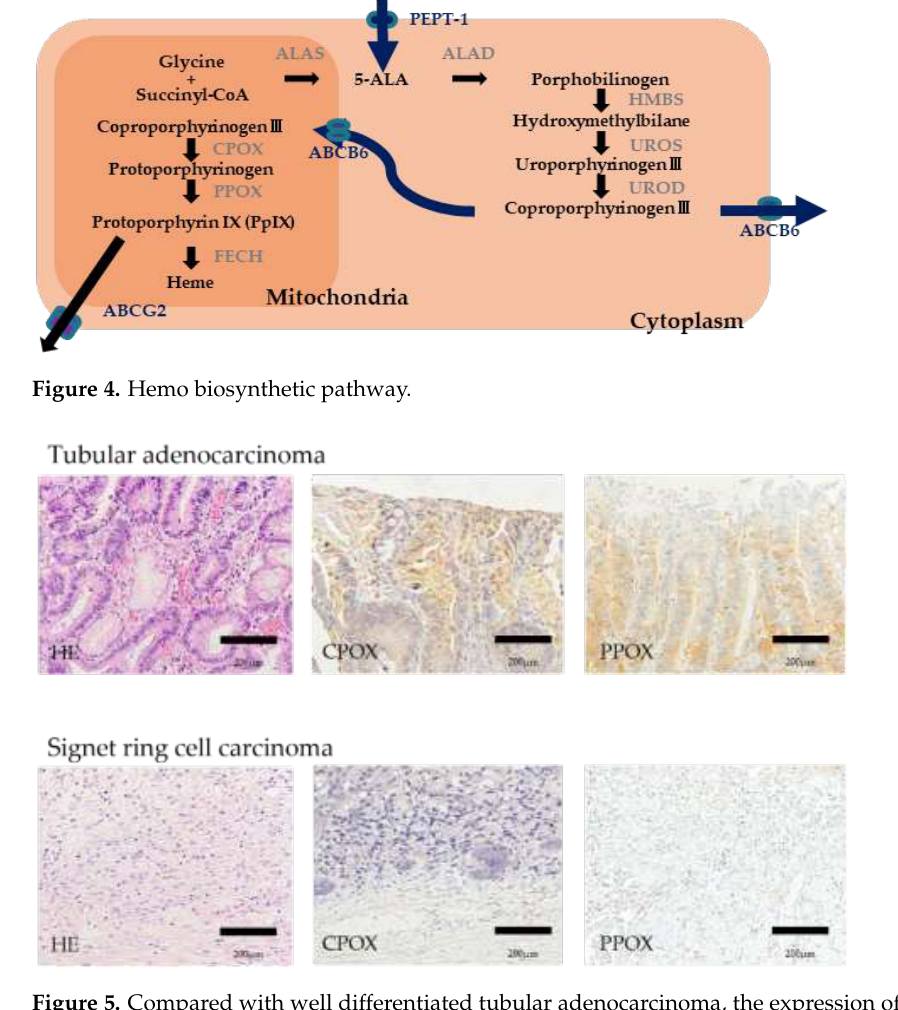
Figure 5. Compared with well differentiated tubular adenocarcinoma, the expression of CPOX and PPOX is decreased in signet ring cell